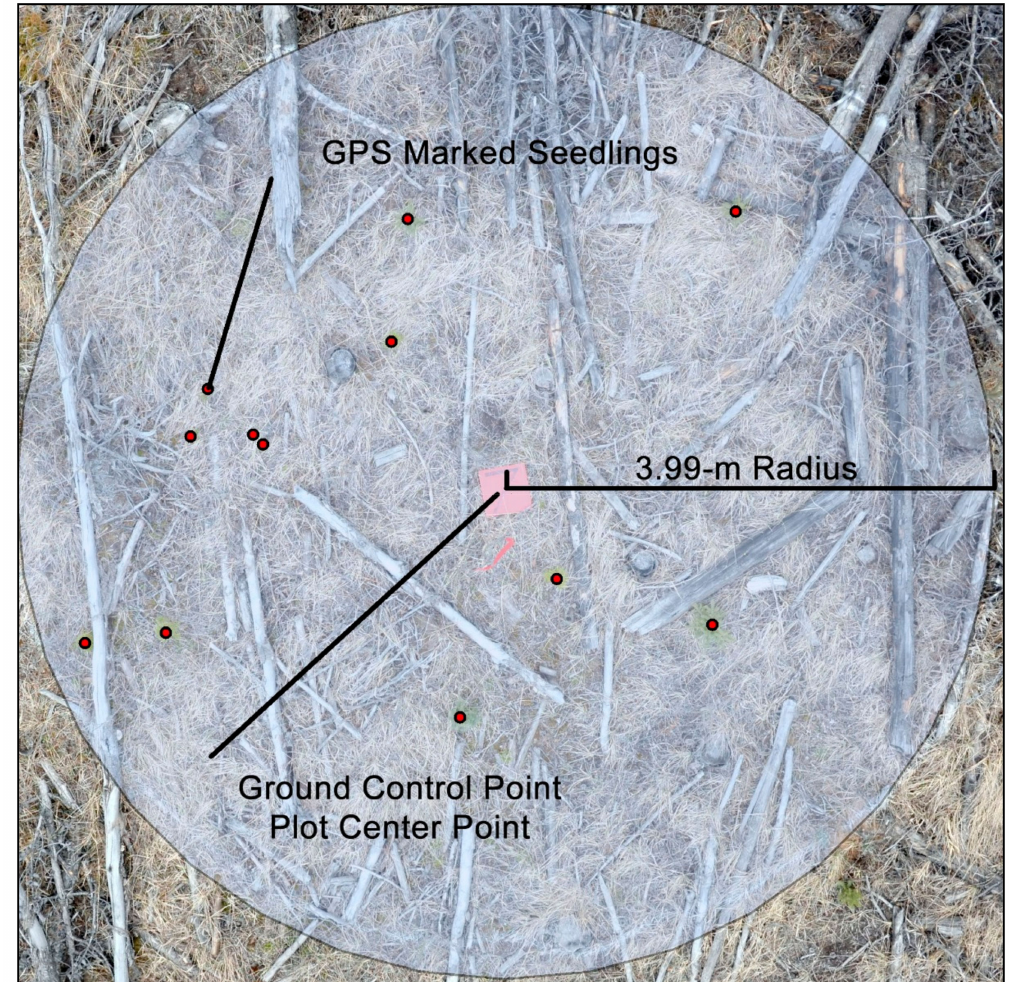
Figure 2. A sample plot, outlined with paint, measured 3.99 m in radius. The coordinates of both ground control point/center point and seedlings were measured using a survey grade global navigation satellite system (GNSS) unit. Note that the image has been clipped to just the plot extent for the purpose of